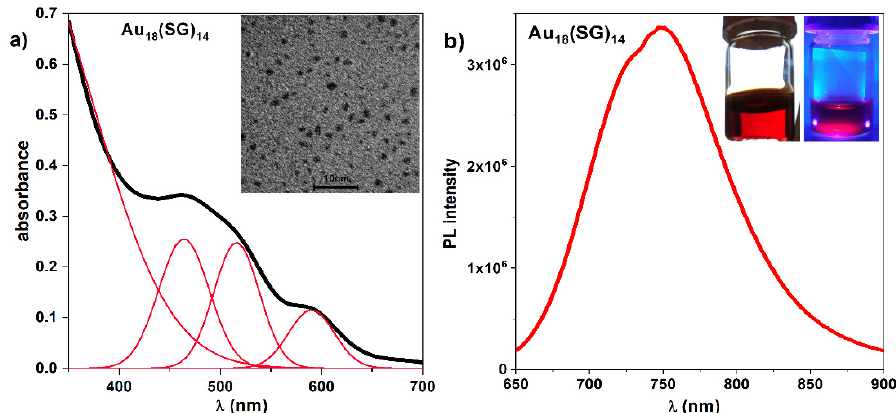
Figure 1. ( a ) Extinction spectra of Au 18 (SG) 14 with marked bands at 465, 515, and 590 nm. Upper right corner presents TEM image of NCs. ( b ) Au 18 (SG) 14 emission spectra with maximum peak position at 750 nm. Photographs in the inset present Au 18 (SG) 14 cluster solution in visible (left) and UV light (right).